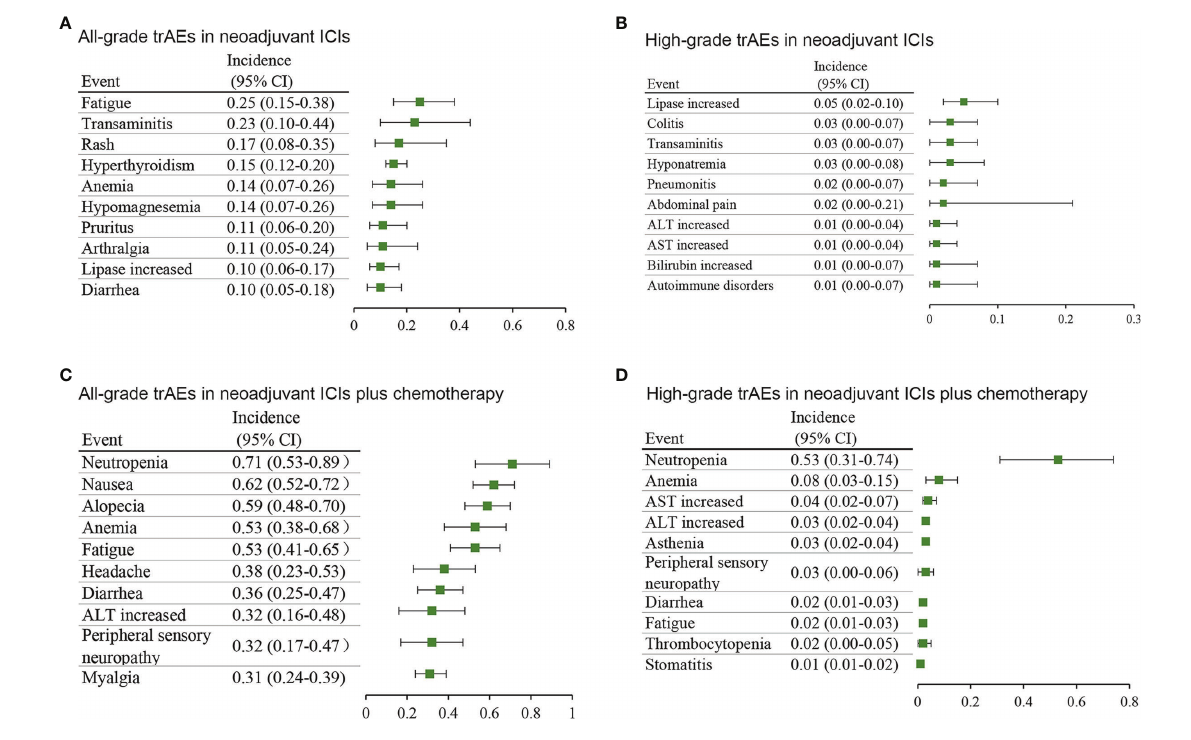
FIGURE 2 | Incidence of the most common treatment-related adverse events in different treatment groups. (A) all-grade and (B) high-grade in neoadjuvant ICIs alone. (C) all-grade and (D) high-grade in neoadjuvant ICIs plus chemotherapy. AST, aspartate aminotransferase; ALT, alanine transaminase; CI, con fi dence